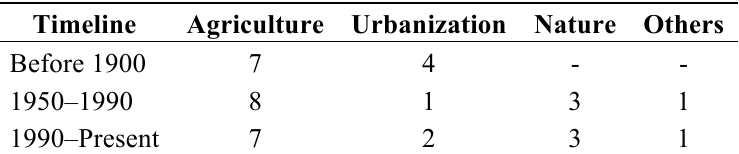
Table 3. Time distribution of driving forces